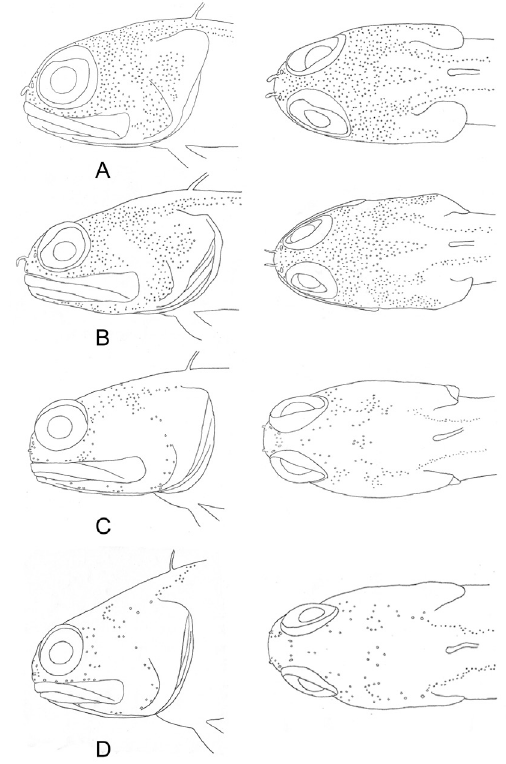
Figure 4. Cephalic sensory pores in selected species of Opistognathus . A O. thionyi , 45.4 mm SL, holo- type B O. vicinus , NPM 5030, 47.4 mm SL, Brazil C O. lonchurus , CIUFES 1426, 75.3 mm SL, Brazil D O . aff. aurifrons , CIUFES 1450, 57.0 mm SL,